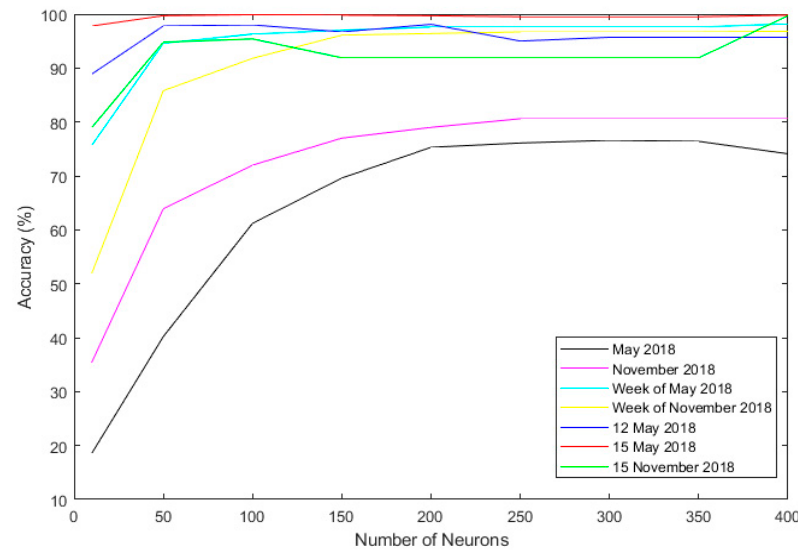
Figure 11. The accuracy for each interval of experiments.